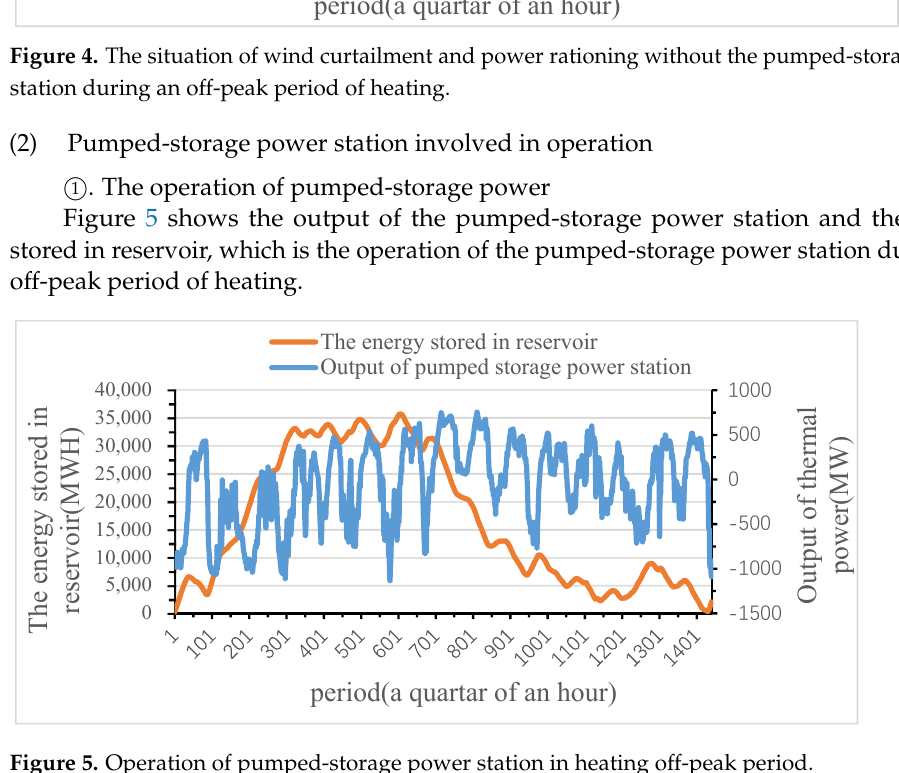
Figure 6. The load composition in heating off-peak period. ③ . The capacity of the pumped-storage power station As shown in Figure 7, when the pumped-storage power station is running while the output of the thermal power plant is stable and the power rationing of the grid is 0, the maximum output of the pumped-storage power station under the power generation con- dition should be reached at 755 MW, and if the wind curtailment of the grid is 0, the max- imum pumping power of the station is 1132 MW. If there is no wind curtailment or power rationing, the pumped-storage power station should have a capacity of 1132 MW. Figure 7. Input capacity and curtailment of wind and power rationing in the off-peak period of heating.